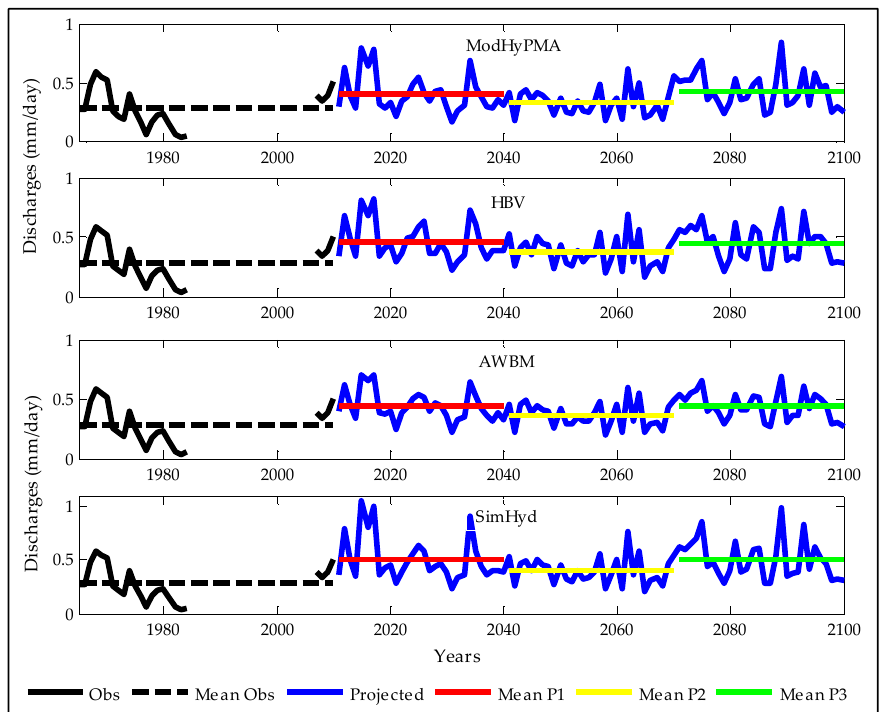
Figure 8. Evolution annual mean of projected discharge according to the RCP4.5 scenario.